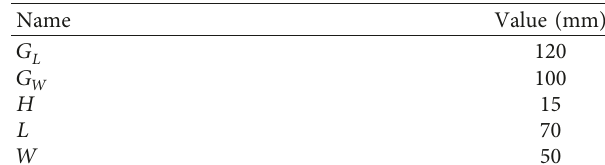
Table 1: Fixed parameters of the E-shaped dual-frequency MSA.